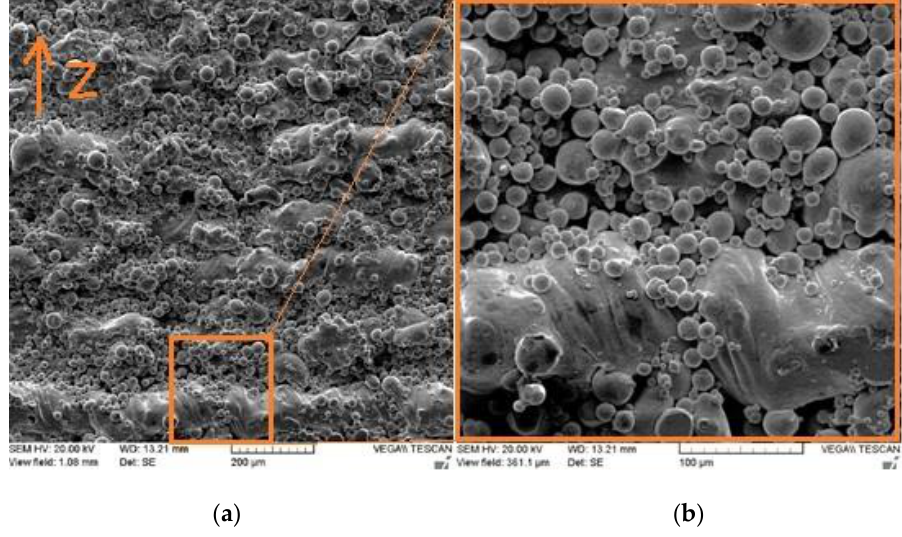
Figure 9. SEM micrographs of the L-PBF Cu part’s side surface at ( a ) low and ( b ) high magnifications.